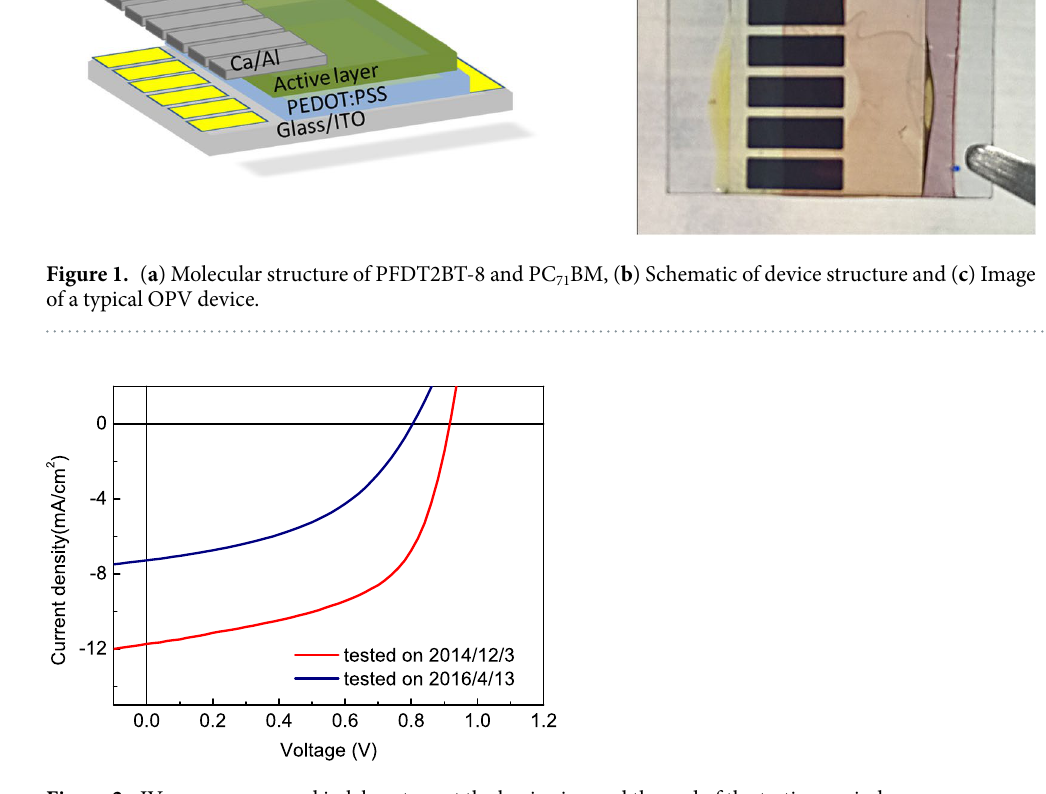
Figure 2. JV curves measured in laboratory at the beginning and the end of the testing